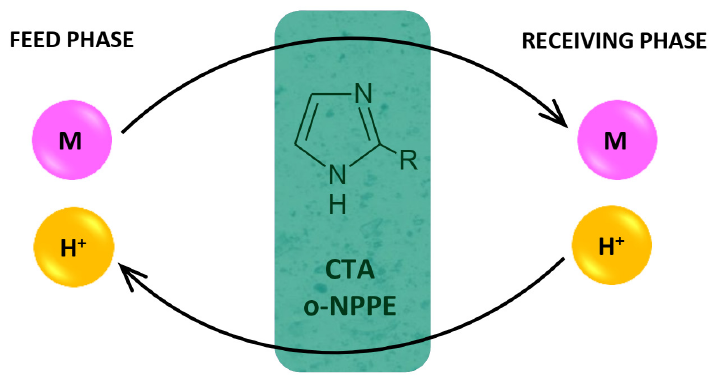
Figure 4. Schematic transport of metal ions across PIM doped 2-alkylimidazoles.